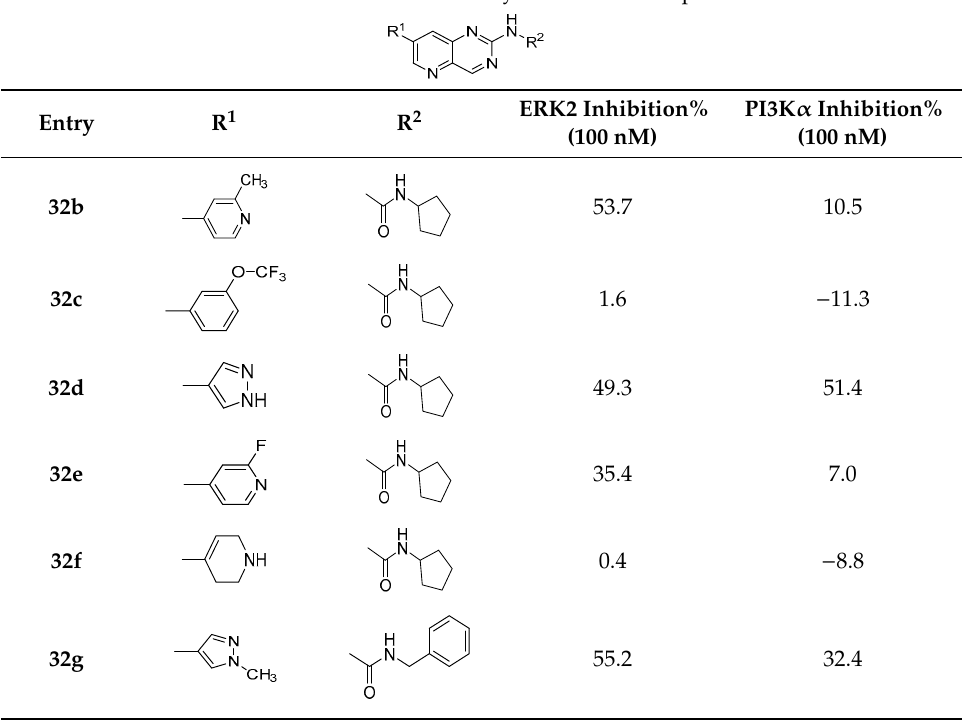
Table 3. In vitro ERK 2 and PI3K α inhibitory activities of compounds 32b ~ 32m .